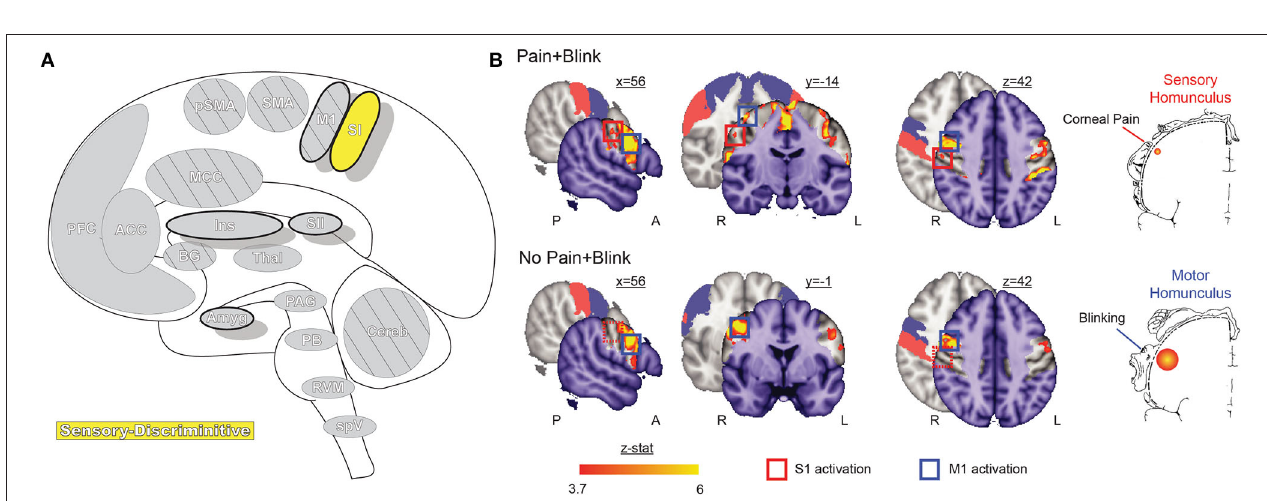
FIGURE 3 | Primary somatosensory cortex. (A) Brain areas active during pain: primary somatosensory cortex (SI) highlighted. (B) Functional imaging during exposure to bright light while in a photophobic state results in significant activation along the rostral face portion of the SI somatotopic map, contralateral to the site of corneal abrasion. SI activity is no longer present after symptoms resolve, while bilateral M1 and some bilateral SMA activation, associated with blinking, is seen in both conditions. Reprinted from PLOS ONE, Vol 7(9), EA Moulton, L Becerra, P Rosenthal, D Borsook, An approach to localizing corneal pain representation in human primary somatosensory cortex, e4463, Copyright (2012) Moulton et al., under the Creative Commons Attribution License (CC-BY). DOI: https://doi.org/10.1371/ journal.pone.0044643SI, primary somatosensory cortex; M1, primary motor cortex; A, anterior; L, left; P, posterior; R,